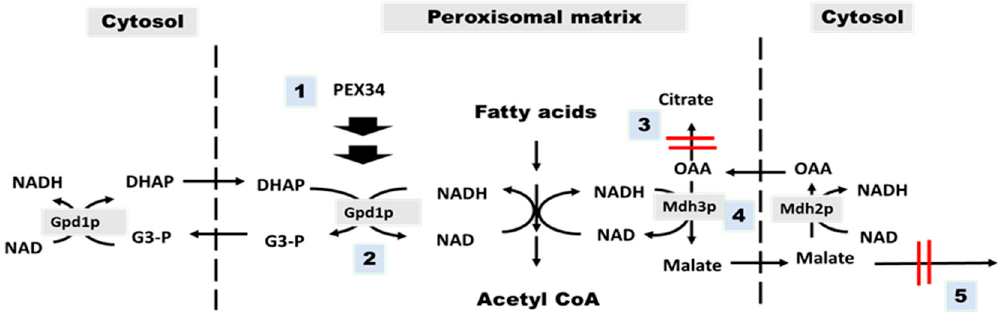
Figure 7. Summary of genetic mechanisms to restore the chronological longevity of agc1 Δ yeasts. There are five genetic mechanisms for restoring the longevity of agc1 Δ yeasts, including activation of PEX34 over-expression ( 1 ), GPD1 over-expression ( 2 ), deletion of CIT2 ( 3 ), MDH3 over-expression ( 4 ), and deletion of ODC1 ( 5 ). The principle of the genetic mechanism for restoring longevity of agc1 Δ yeasts is that induction of GPD1-mediated NAD regeneration in peroxisomes ( 1 , 2 ) and enhanced peroxisomal malate–oxaloacetate NADH shuttle activity ( 3 – 5 ). Abbreviations: Asp, aspartate; Glu, glutamate; OAA, oxaloacetate; α -KG, α -ketoglutarate, Agc1p, aspartate–glutamate carrier, Odc1p, oxodicarboxylate carrier; Mdh3p, malate dehydrogenase3; Mdh2p, malate dehydrogenase2; Cit2p, citrate synthase2; Gpd1p, glycerol 3-phosphate dehydrogenase 1; DHAP, dihydroxyacetone phosphate; G3-P, glycerol 3-phosphate.